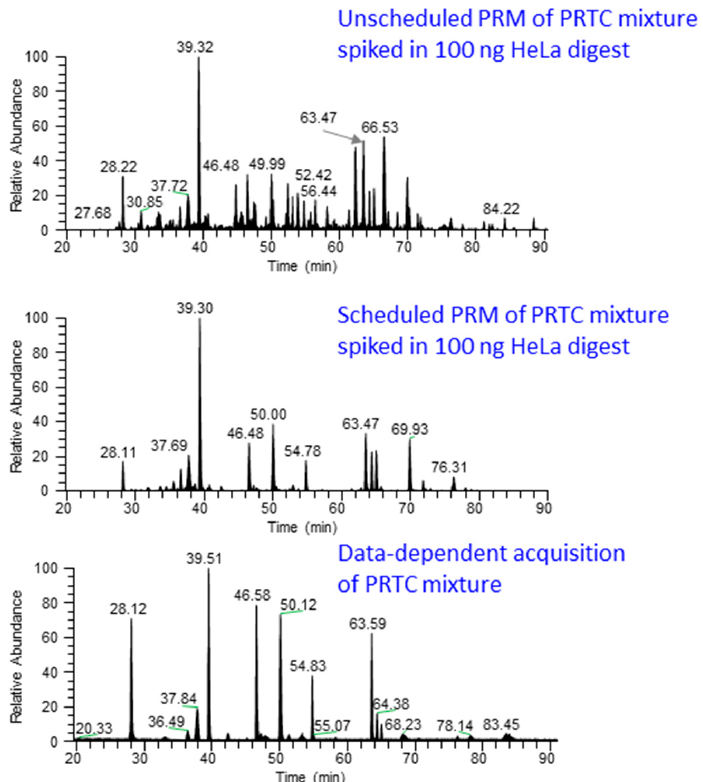
Figure 3. Comparison of scheduled and unscheduled PRM method. PRM analysis by scheduling the elution time of PRTC (Pierce Peptide Retention Time Calibration mixture, Catalog number: 88321) peptides spiked in 100 ng HeLa digest produces “cleaner” data ( middle panel) compared to unscheduled PRM analysis ( top panel). In the scheduled method, chromatographic peaks are only observed for the target peptides while unscheduled analysis contains noise peaks, possibly from the near-isobaric peptide ions. The lower panel shows the chromatographic profile from data-dependent acquisition of pure PRTC peptides.